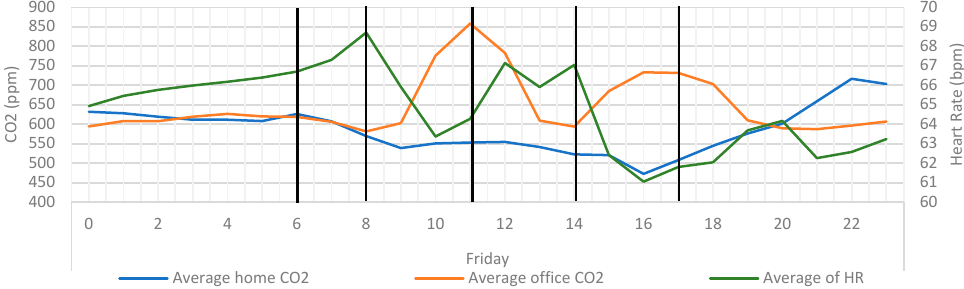
Figure 12. Average home/office CO 2 overlayed with average heart rate and key event markers. Vertical black lines signify the point when CO 2 rise or falls.